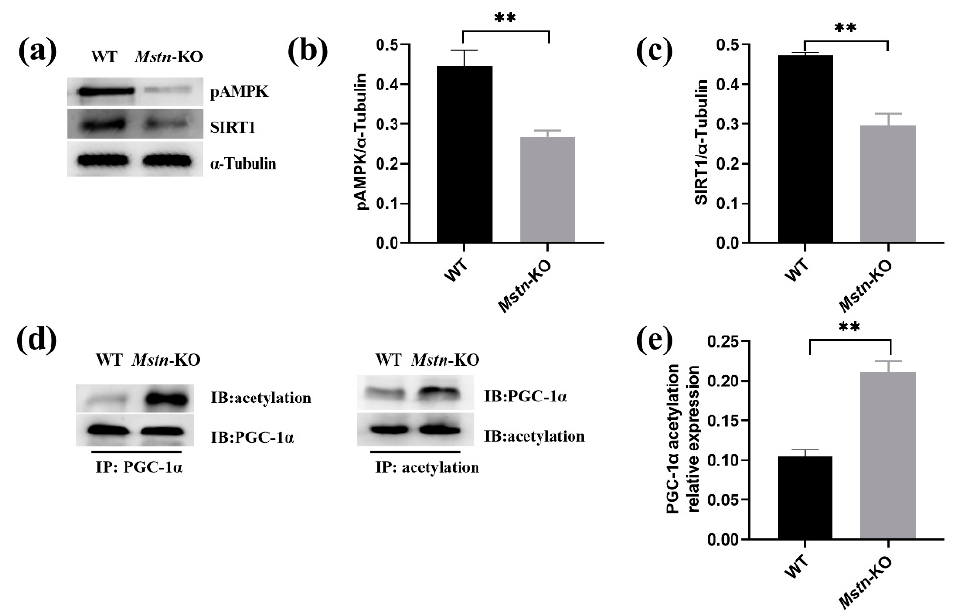
Figure 6. Mstn knockout inhibited the AMPK/SIRT1/PGC1alpha pathway. ( a ) The expression of SIRT1 and pAMPK at the protein level in Mstn -KO and WT mice. ( b ) Gray intensity analysis of pAMPK/ α -Tubulin ( n = 3). ( c ) Gray intensity analysis of SIRT1/ α -Tubulin ( n = 3). ( d ) Acetylation level of PGC1 α protein by co-immunoprecipitation in Mstn -KO and WT mice. ( e ) Gray intensity analysis of acetylation level of PGC1 α ( n = 3). All data are presented as mean ± SD. ** p < 0.01; t-tests were used to calculate the p -values.